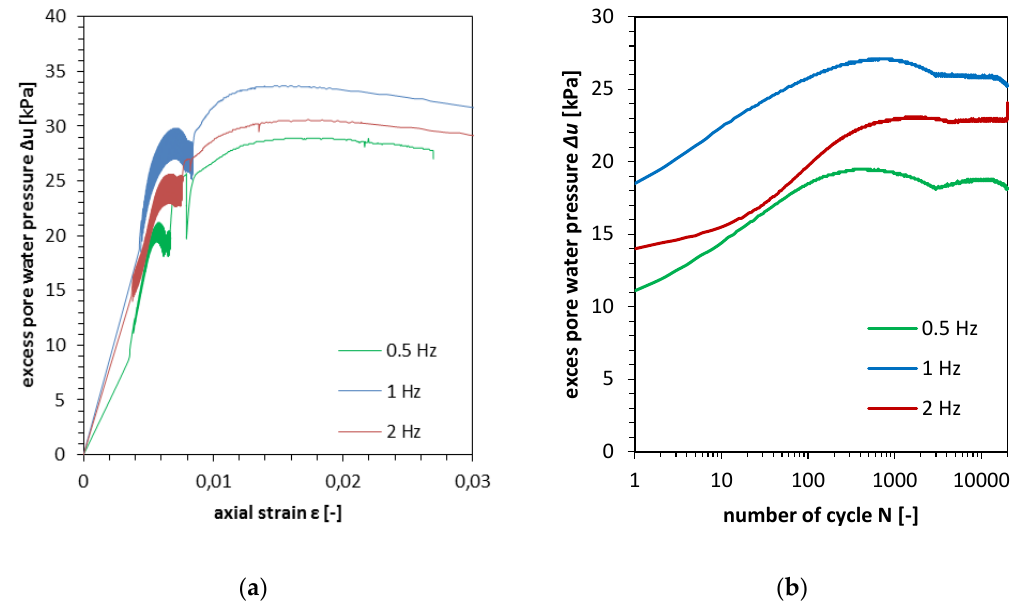
Figure 8. Excess pore water pressure during cyclic triaxial tests: ( a ) ∆ u value versus vertical strain ε ; ( b ) ∆ u value versus number of cycles N .